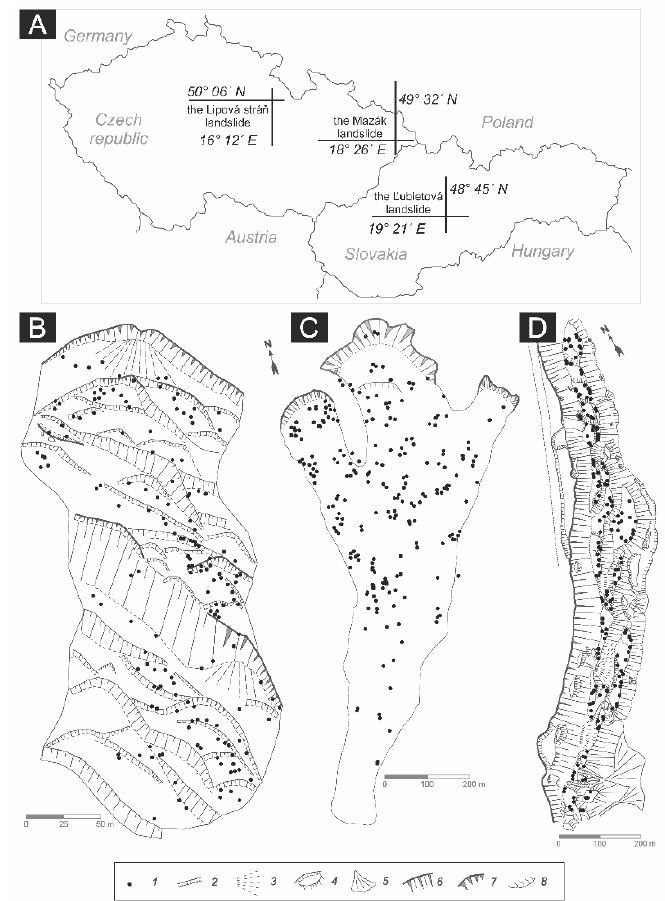
Figure 1. The locations of the studied localities in the Czech Republic and Slovakia ( A ), as well as geomorphic maps of the Maz á k landslide ( B ), the L’ubietov á landslide ( C ), and the Lipov á str á ˇn landslide ( D ) ( 1 —sampled trees; 2 —gully; 3 —talus; 4 —partial landslide block; 5 —alluvial fan; 6 —main scarp; 7 —rock exposure; 8 —accumulation